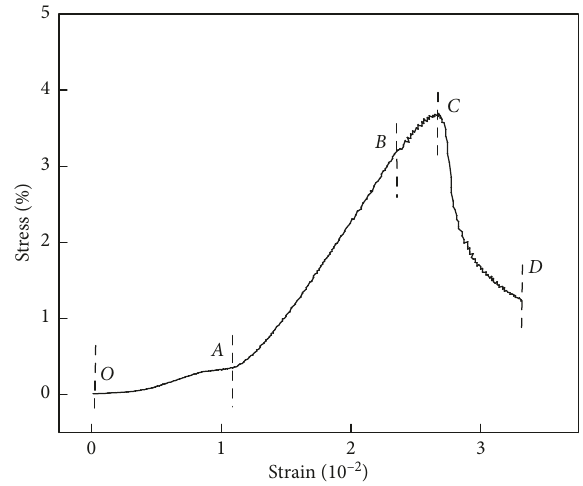
Figure 8: Stress-strain curve of plain